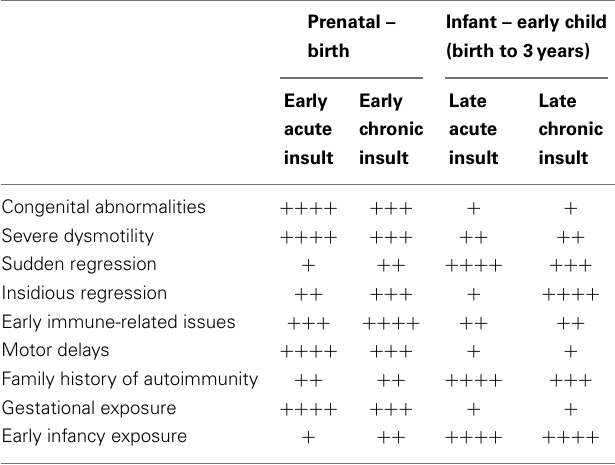
Table 3 | Broad clinical sub-categories